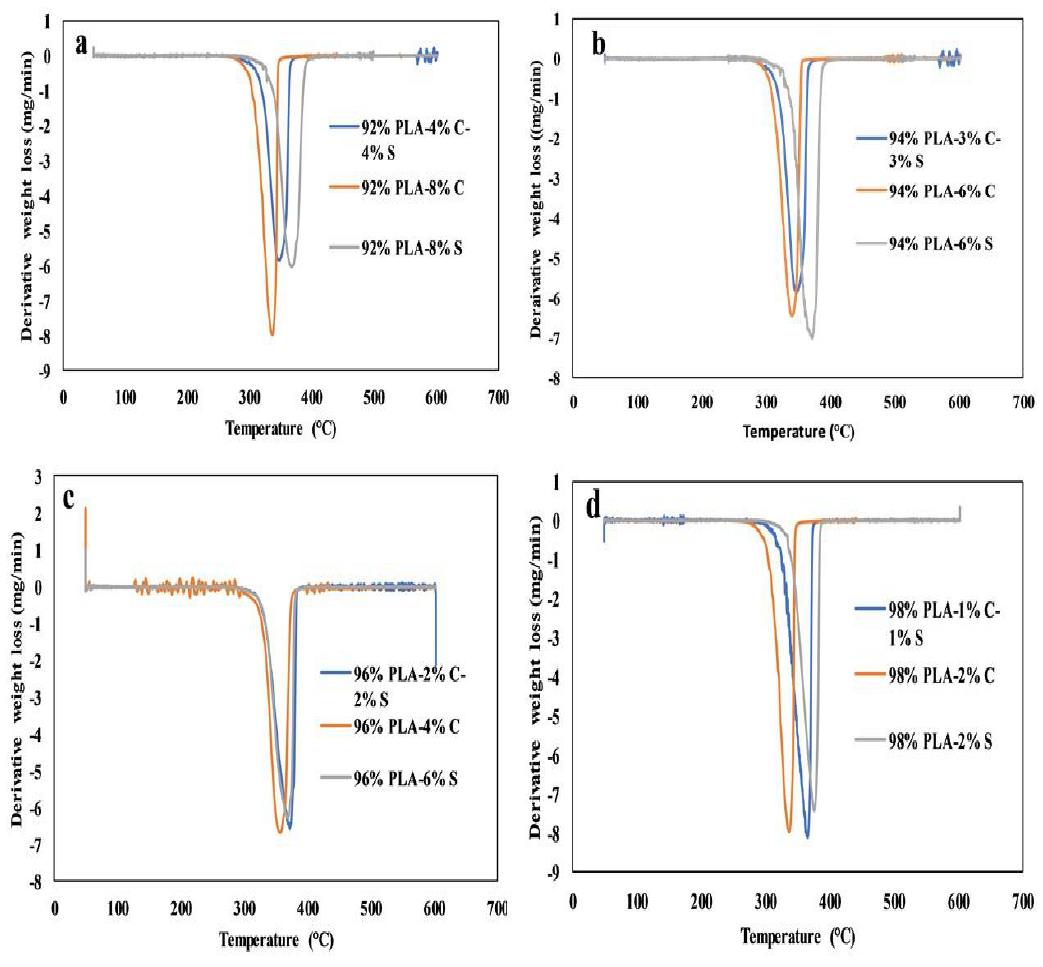
Figure 7. Derivative Thermogravimetry Analysis (DTA) for ( a ) 92%, ( b ) 94%, ( c ) 96% and ( d ) 98% PLA sets of samples.